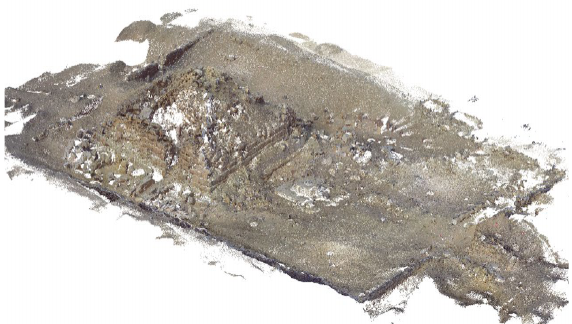
Figure 3: laser scanner survey: the final model of the temple acquired in 2014.